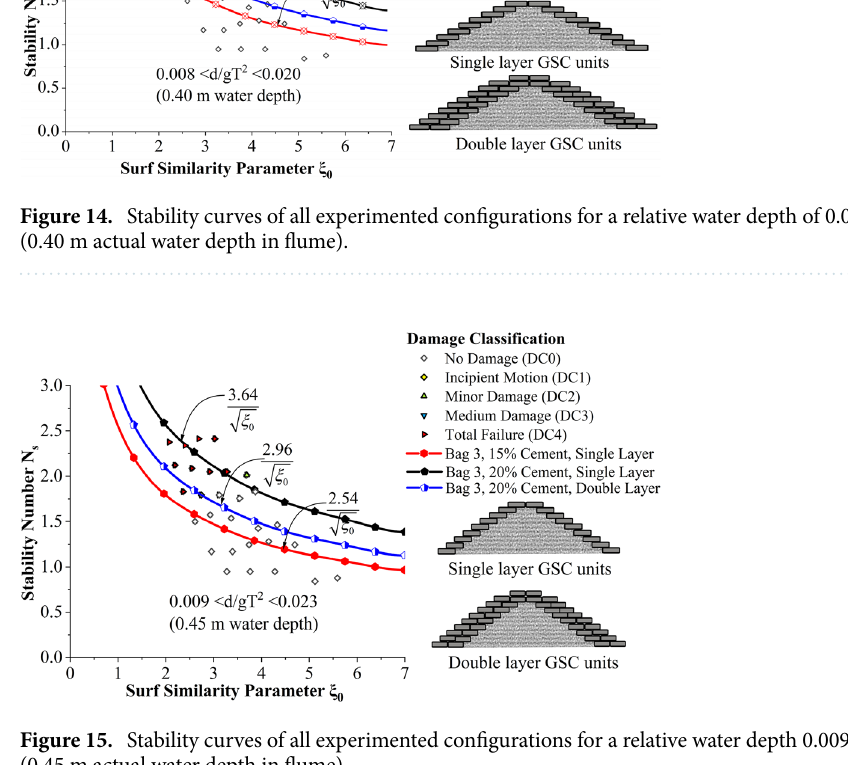
Figure 15. Stability curves of all experimented configurations for a relative water depth 0.009 < d/gT 2 < 0.023 (0.45 m actual water depth in